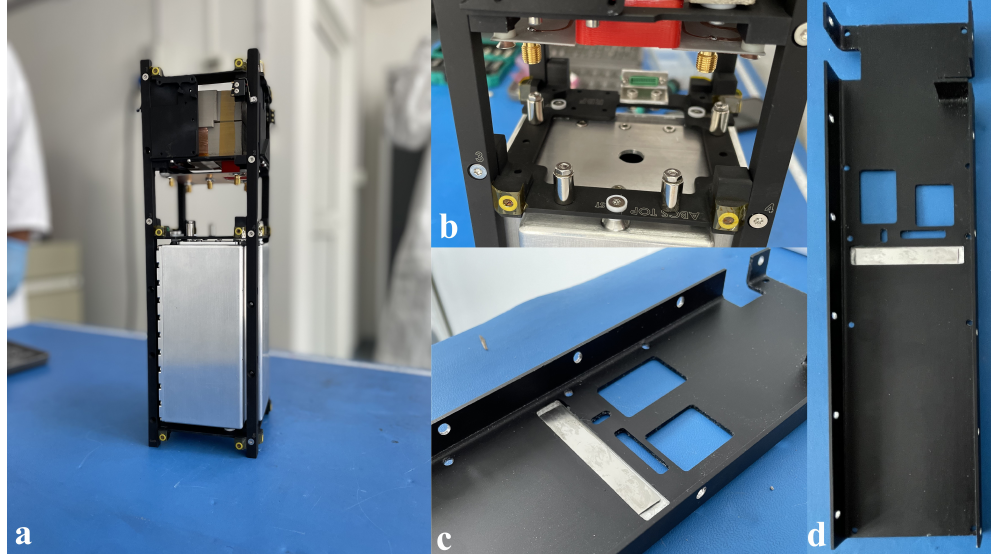
Figure 3. The structure of ABCS ( a ) and the position of the four permanent magnets ( b ) and four hysteresis strips ( c , d ) in